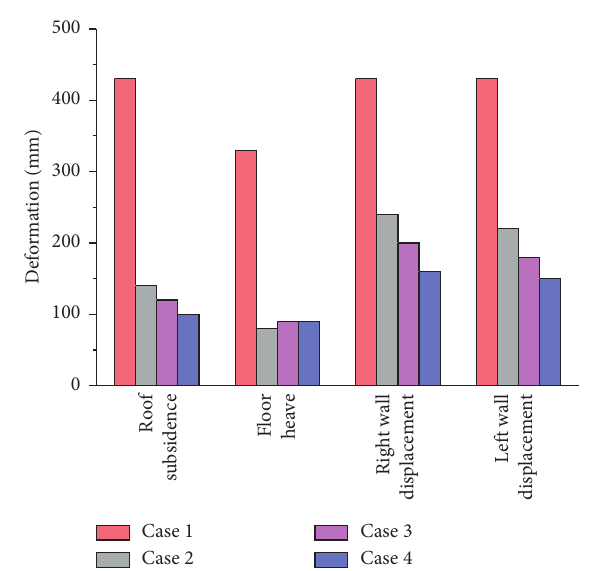
Figure 8: Summary of simulated results of deformation for all cases